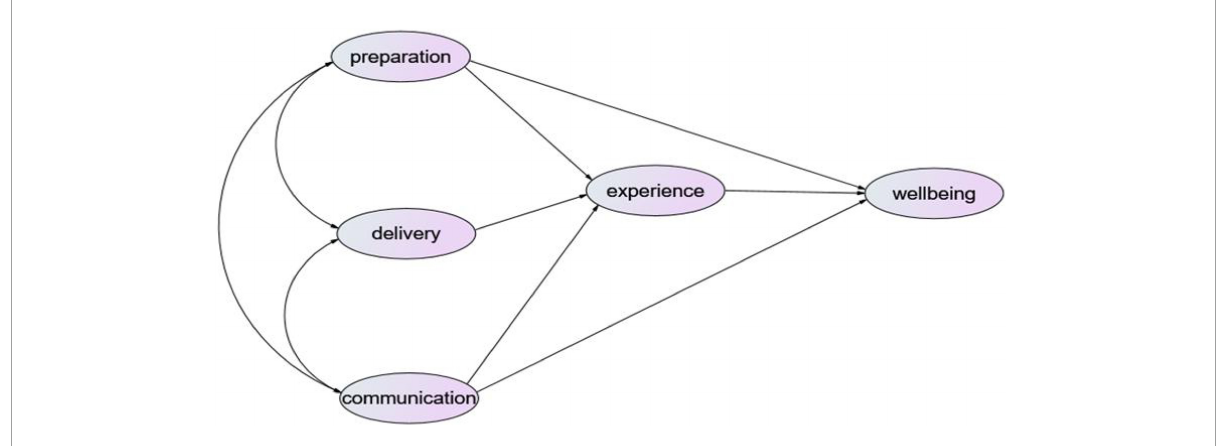
FIGURE1 The hypothetical model of the mechanisms influencing teachers’